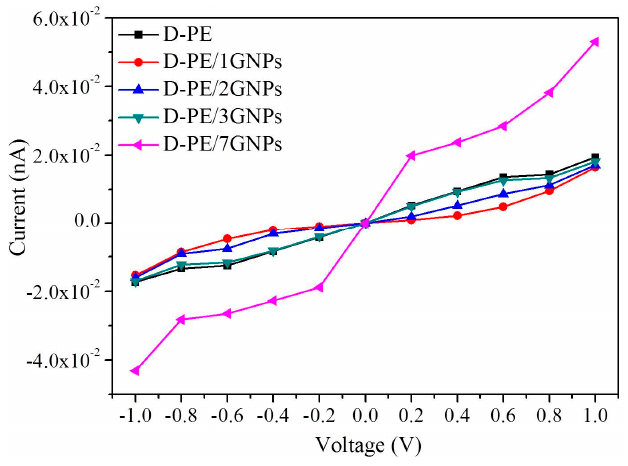
Figure 5. Computed I - V curves of D-PE, D-PE/1GNPs, D-PE/2GNPs, D-PE/3GNPs, and D-PE/7GNPs two-probe devices.